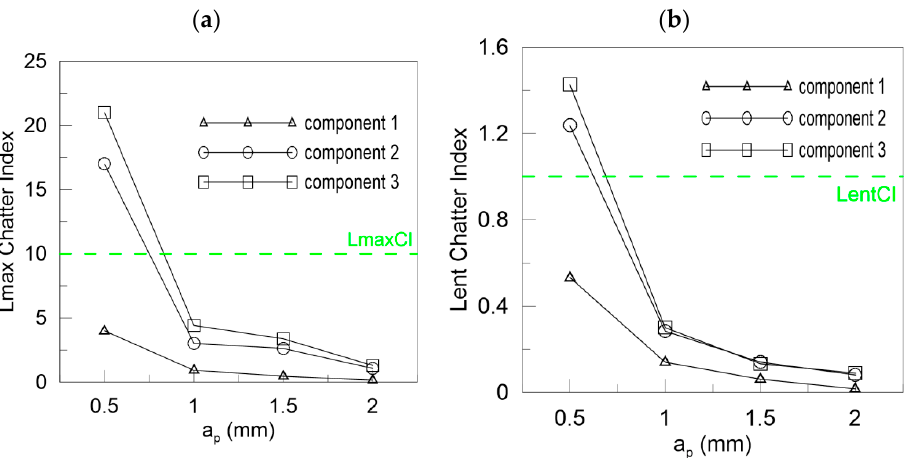
Figure 19. Chatter indexes for F xy versus depth of cut: ( a ) the L max and ( b ) L ent chatter index.